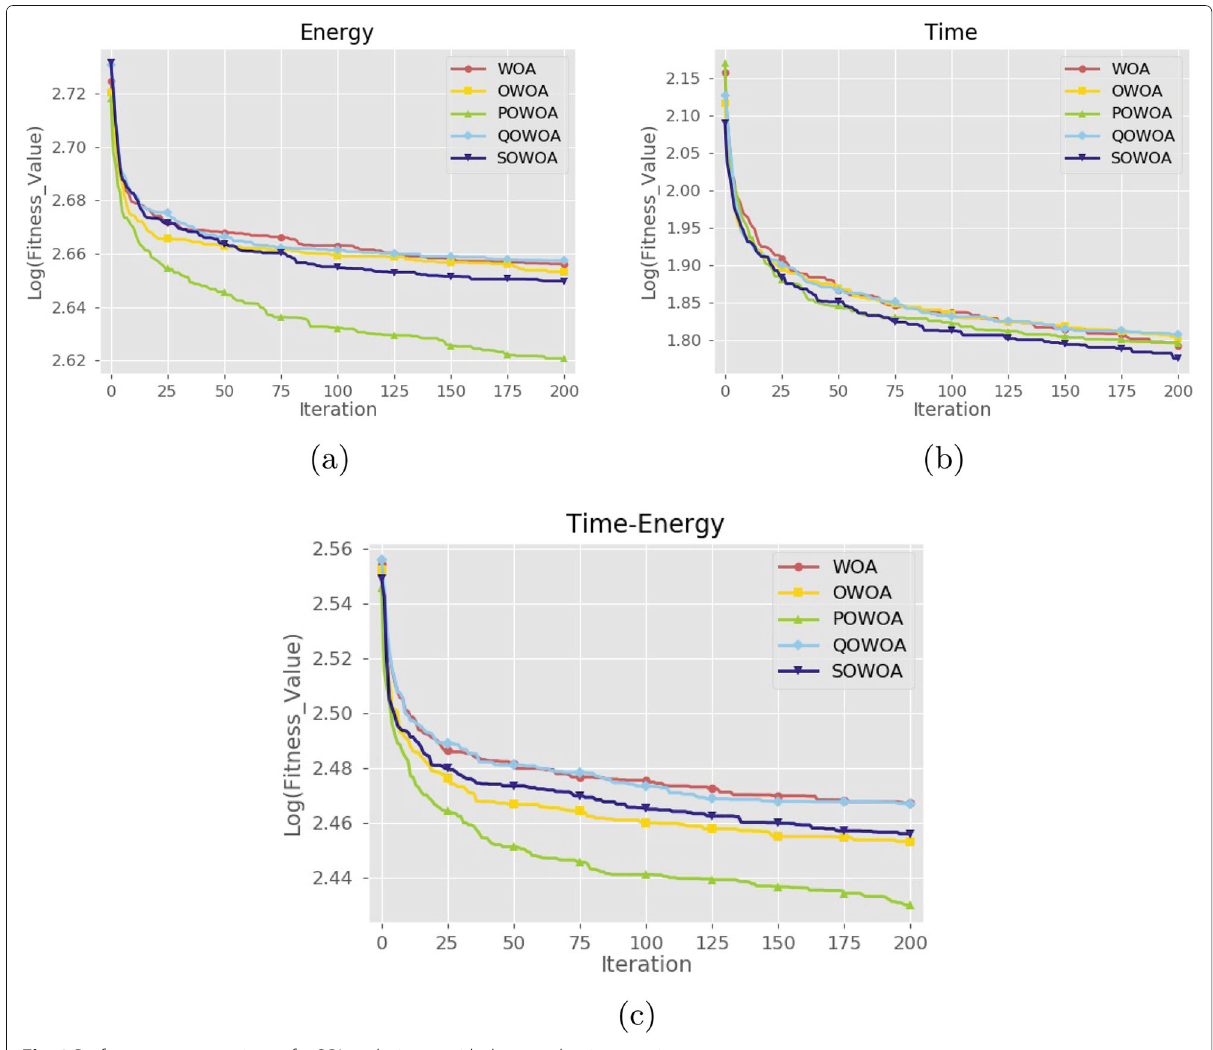
Fig. 9 Performance comparison of 4 OBL techniques with three evaluation metrics better results than the linear function; also, Beta2 shows the best results out of other functions while achieving a balance between time and energy